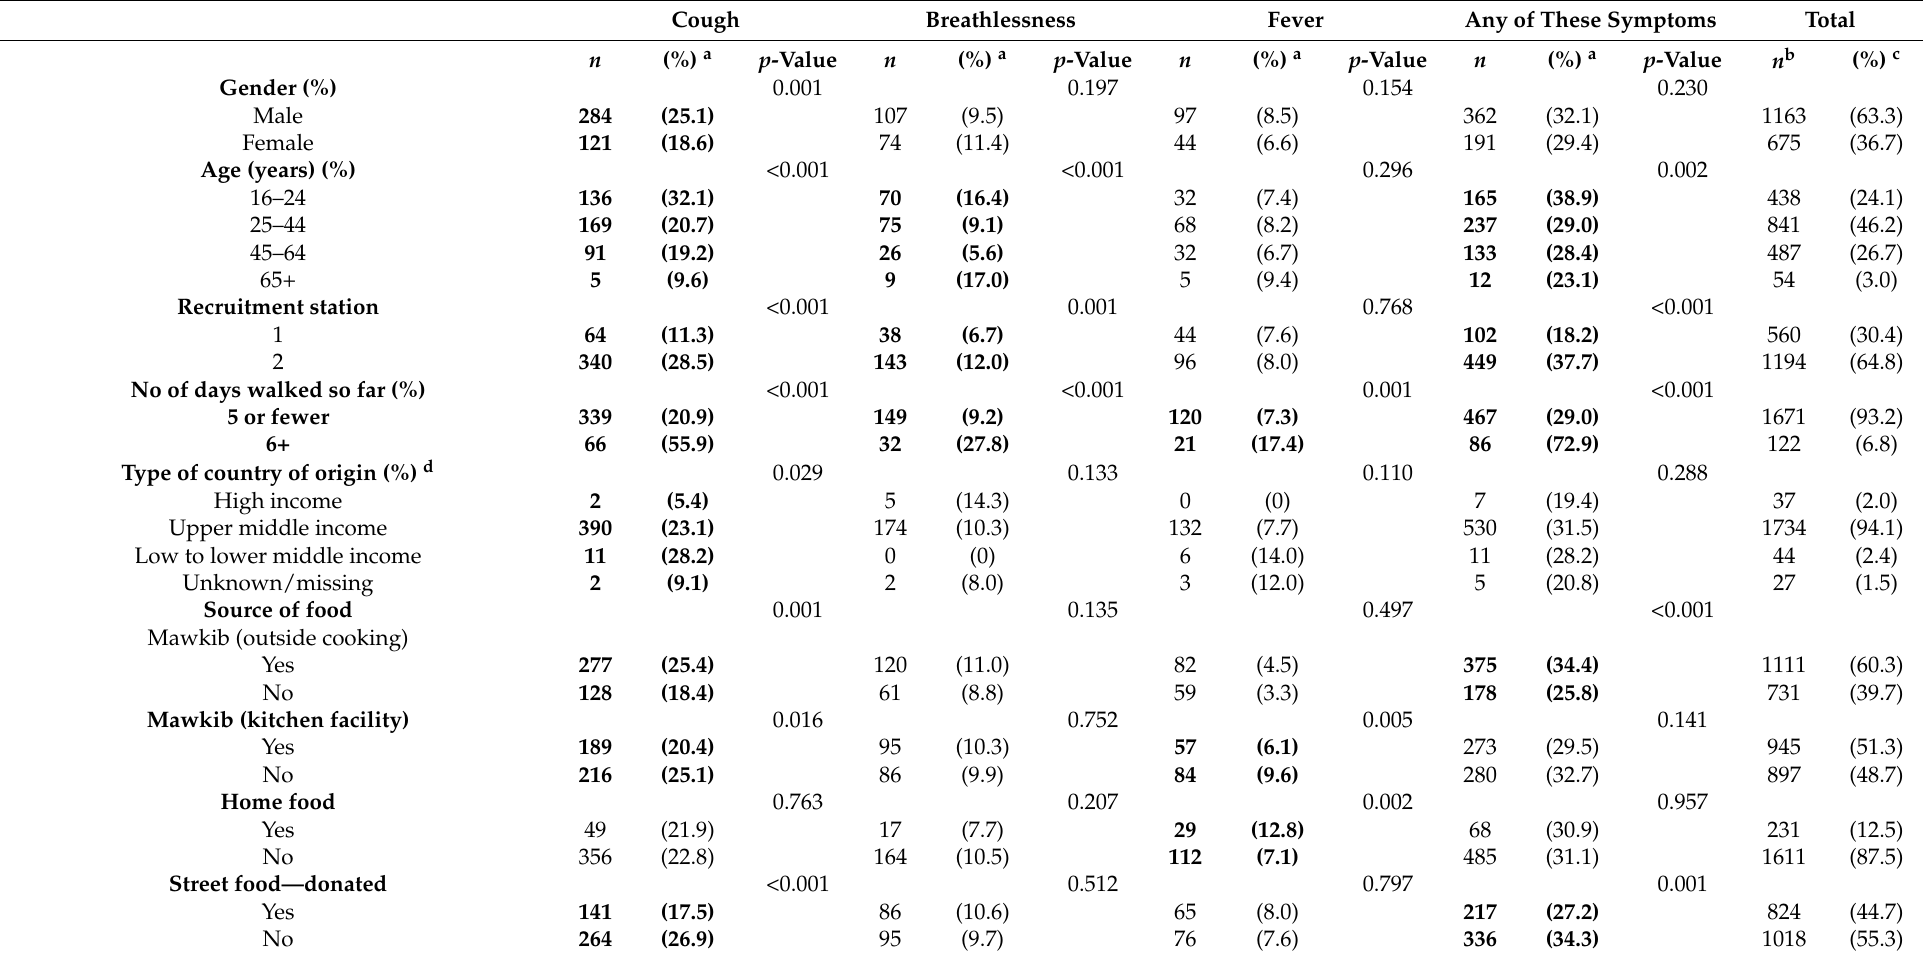
Table 3. Predictors of respiratory symptoms that developed during the walk in 1842 Arbaeen